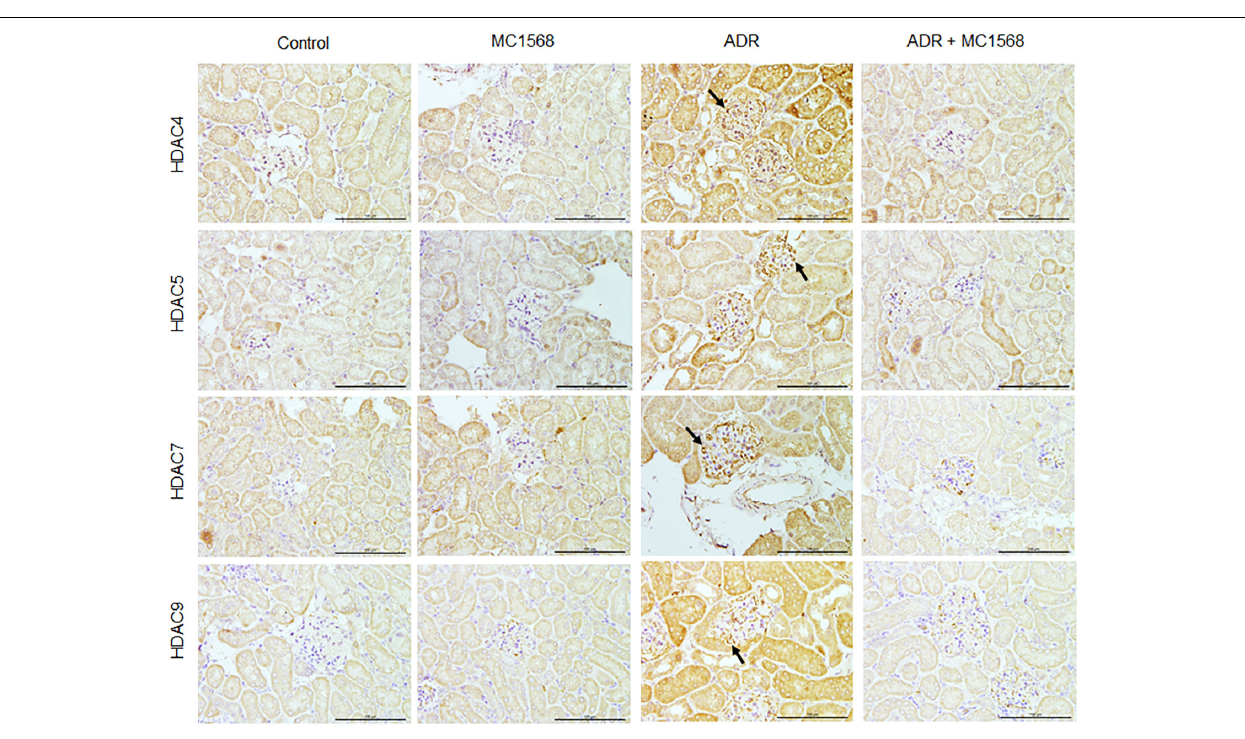
FIGURE 6 | Inhibitory effects of MC1568 on HDAC IIa members. Representative images of immunohistochemical (IHC) of HDAC IIa members including HDAC4, HDAC5, HDAC7, and HDAC9 in control and ADR-injected mice treated with or without MC1568. Scale bar, 100 µ